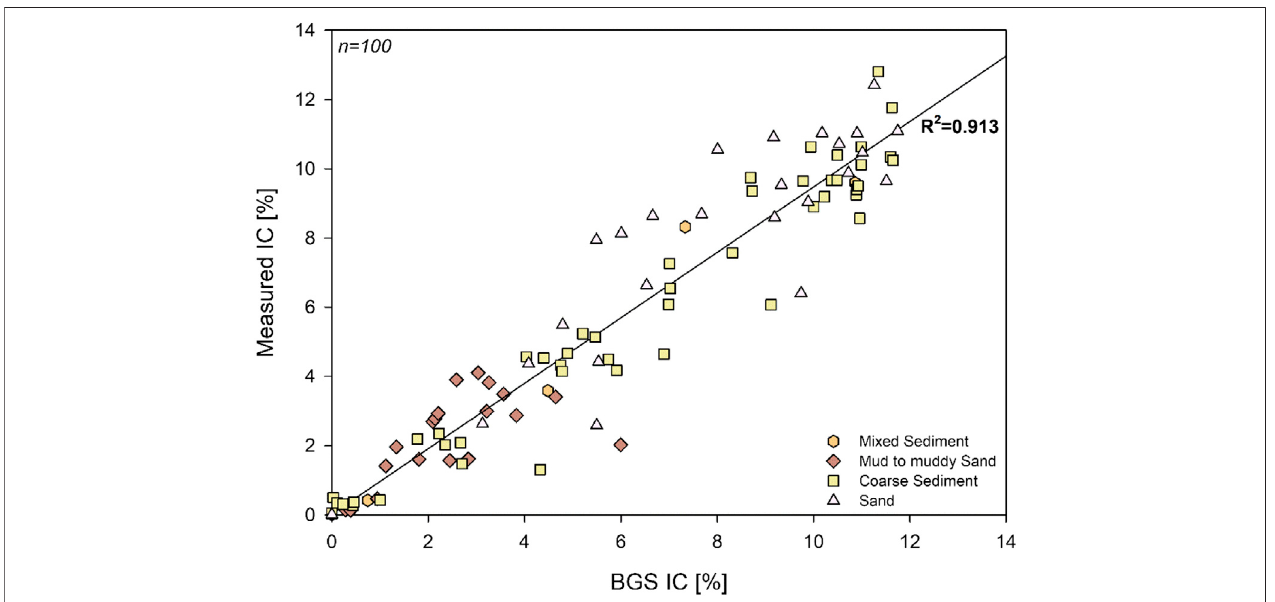
FIGURE 6 | Comparison of IC content [%] of archived samples measured through elemental analysis at the University of St Andrews and legacy BGS data produced through various calorimetric methodologies todetermineCaCO 3 content. The datasets have acoef fi cient of determination ( R 2 ) of 0.913, where y (cid:2) 0.9455 x +